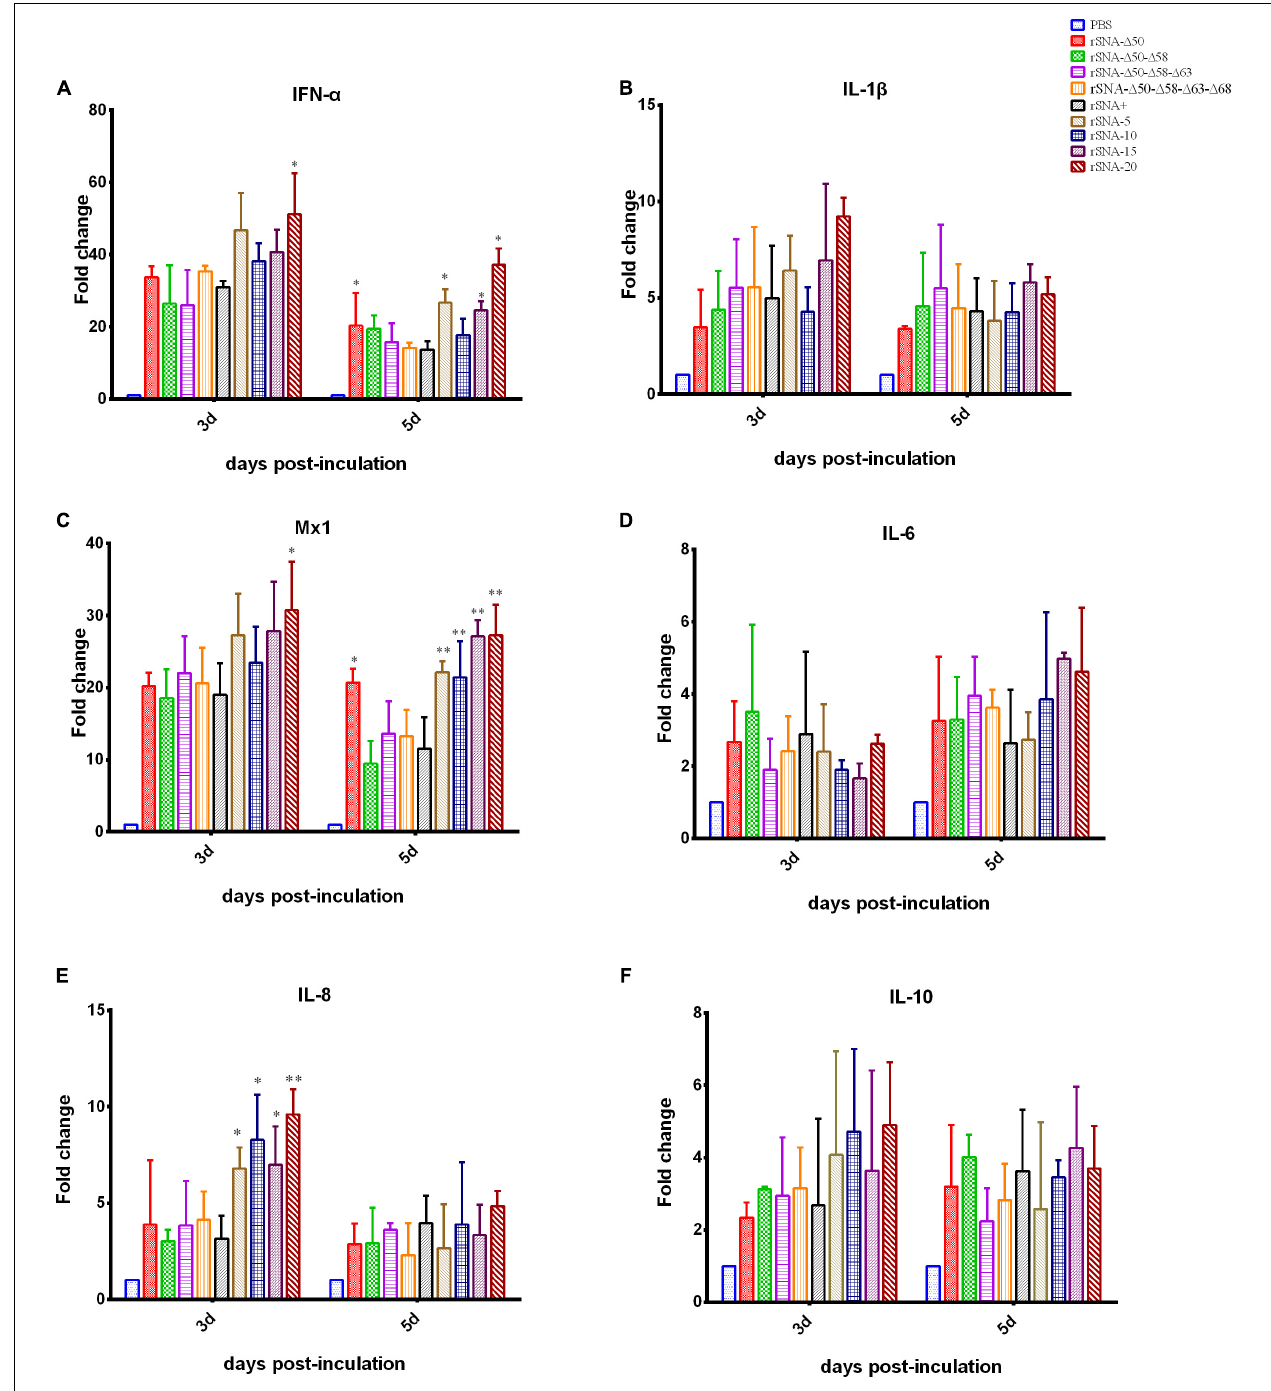
FIGURE 6 | Cytokine response in the lung of the virus-infected mallard ducks. (A) IFN- α , (B) IL-1 β , (C) Mx1, (D) IL-6, (E) IL-8, and (F) IL-10. * P < 0.05, ** P < 0.01, compared to the value of the rSNA+.